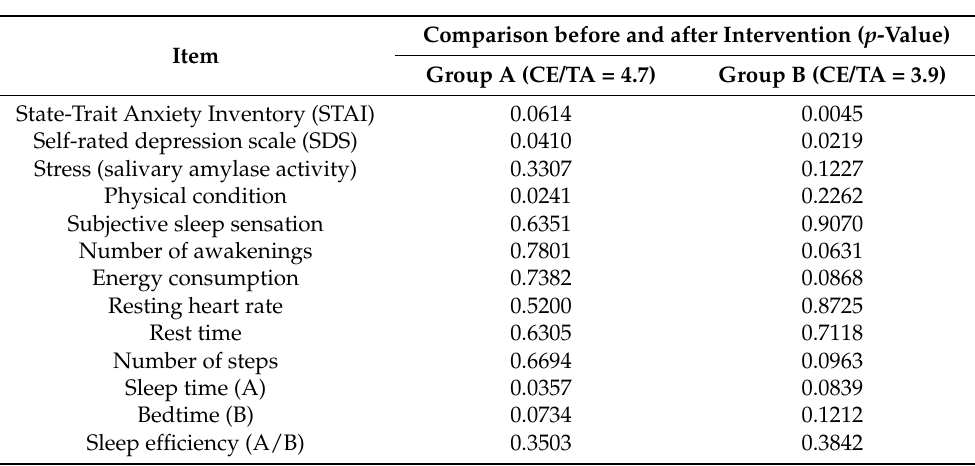
Table 6. Effects of green tea